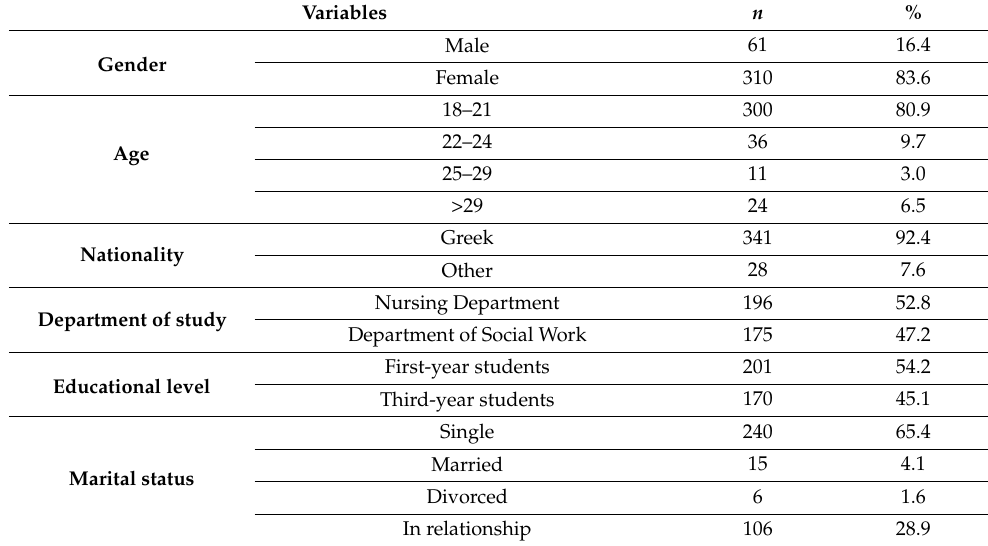
Table 1. Sociodemographic characteristics of the study